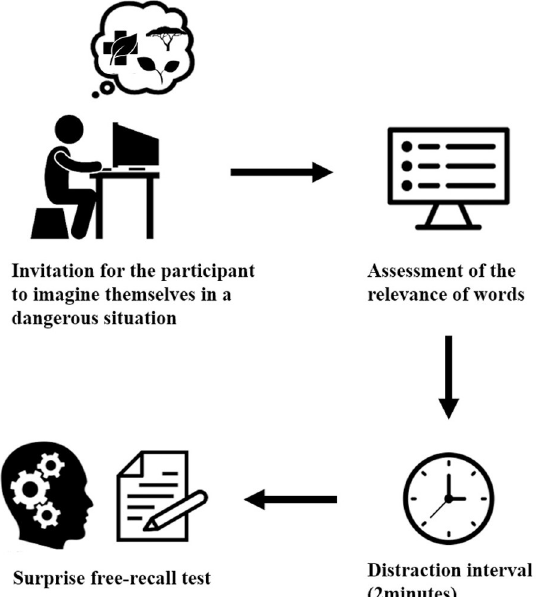
Fig 1. Scheme of the experiment used to analyze the functioning of adaptive memory in simulated situations of danger in ancient and modern environments.